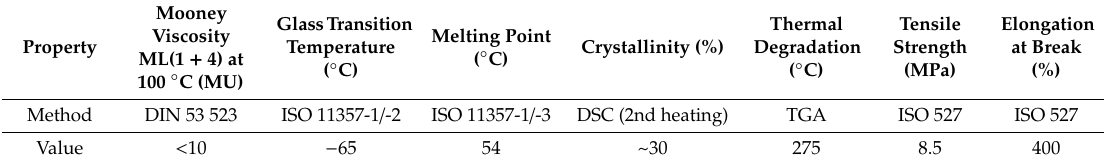
Table 1. Characteristics of trans-polyoctenamer rubber (Vestenamer 8012) *.